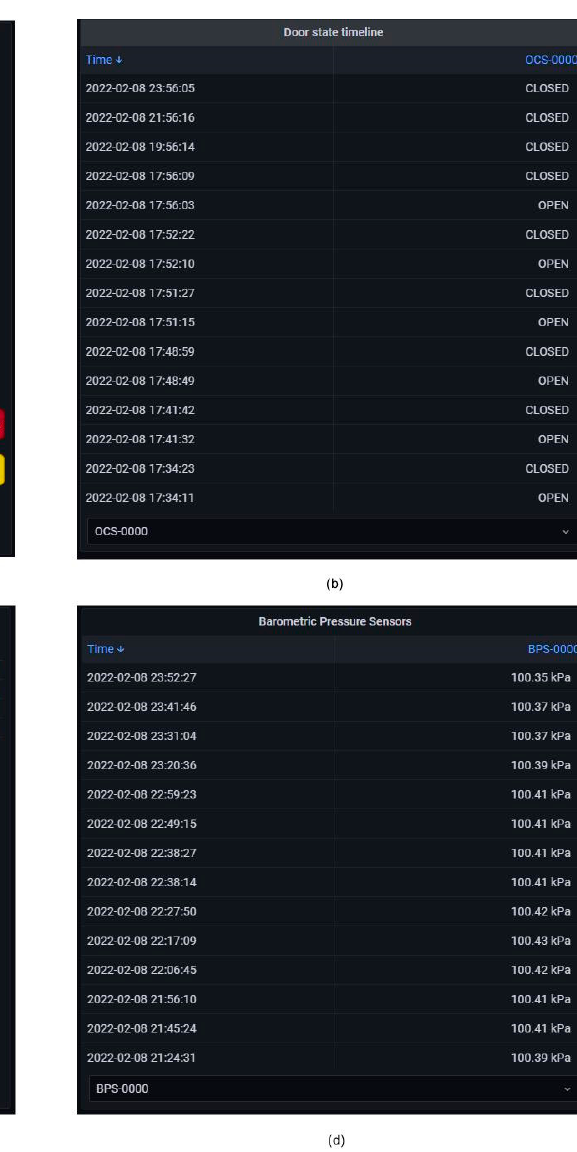
Figure 12. Device Status Dashboard sample: ( a ) Indoor Air Quality Sensor last reading and ( b ) cur- rent status of gateway